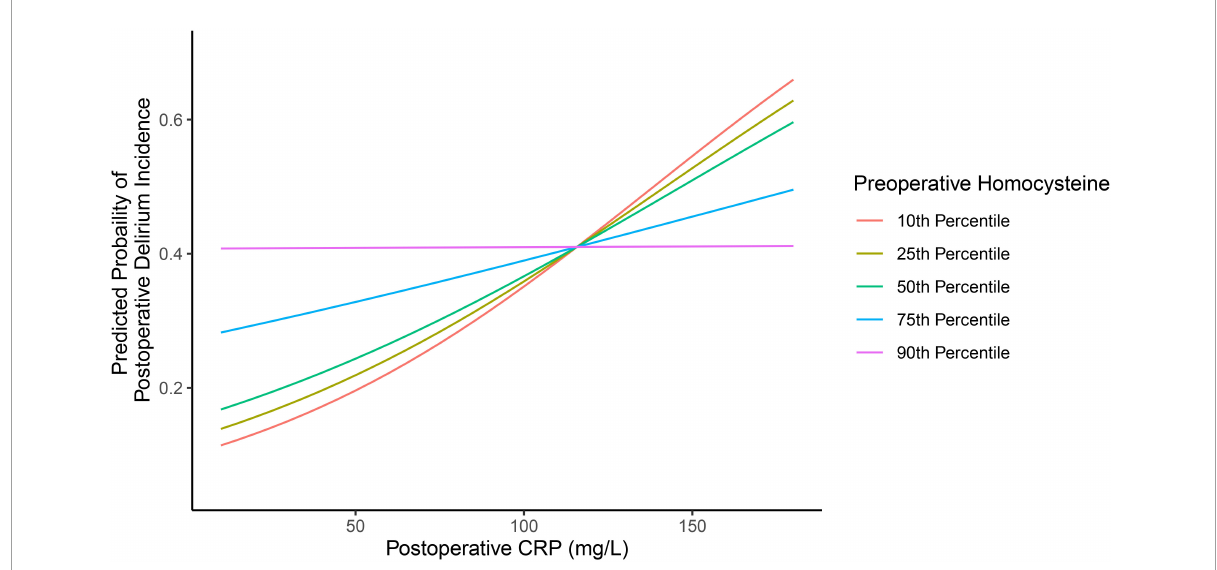
FIGURE2 Different preoperative plasma concentrations of homocysteine lead to different associations between postoperative plasma concentrations of CRP and postoperative delirium incidence. There are different associations between the postoperative plasma concentration of CRP and the postoperative delirium incidence in the participants, with the preoperative plasma concentration of homocysteine at the 10th percentile, 25th percentile, 50th percentile, 75th percentile, and 90th percentile. The data suggest that the preoperative plasma concentration of homocysteine can modify the association between the postoperative plasma concentration of CRP and the postoperative delirium incidence. CRP, C-reactive